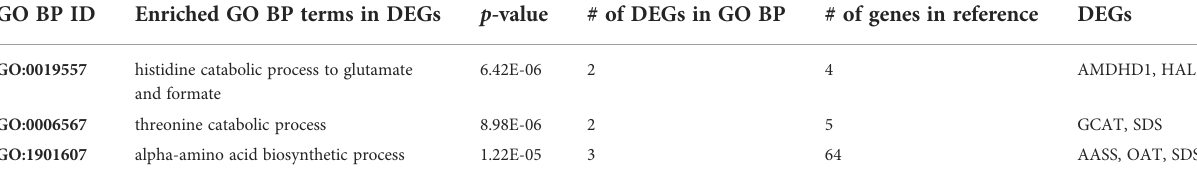
TABLE 4 GO BP enrichment analysis on 14 validated NASH